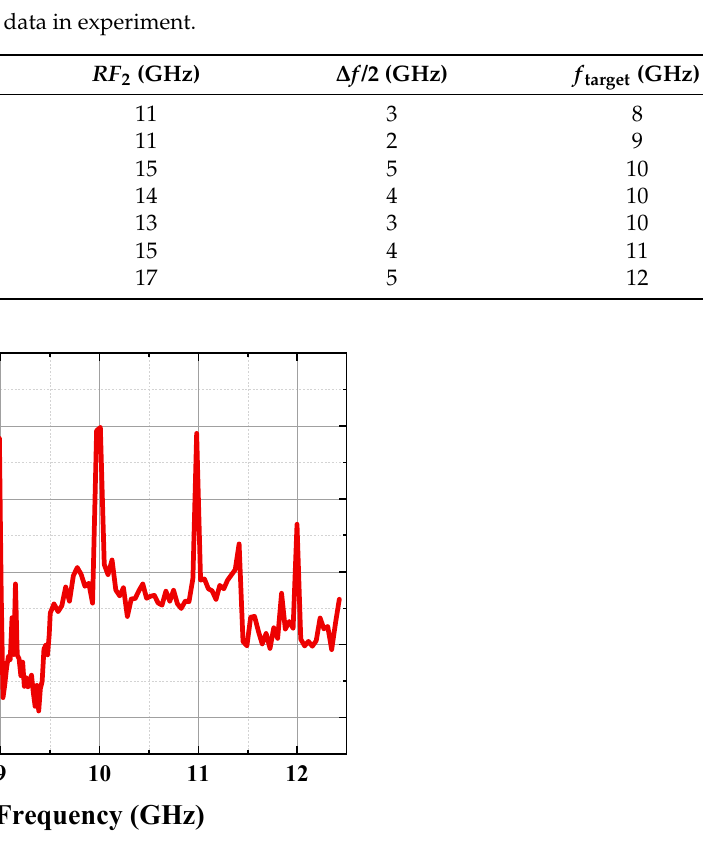
Figure 5. Electrical spectrum of the proposed all-optical microwave frequency divider. As shown in Figure 6, with the change in RF 1 and RF 2 signals, we keep the f target as 10 GHz. The RF 1 signal is 5 GHz, 6 GHz, 7 GHz, respectively. The RF 2 signal is 15 GHz, 14 GHz, 13 GHz, respectively. The frequency divider corresponding to the change of different RF 1 and RF 2 signals has different frequency division factors, and the final target frequency signal is 10 GHz. The corresponding power of the state noise and frequency peak value under different frequency division factors is different. By controlling the RF signals, the proposed all-optical microwave frequency divider can achieve different frequency division factors. The systems parameters such as optical power and SL frequency can be optimized to extend the signal noise rate (SNR). In Figure 6, the State1 ( RF 1 = 5 GHz, RF 2 = 15 GHz) has the SNR over 22 dBm, and the State 2 ( RF 1 = 6 GHz, RF 2 = 14 GHz) and the State 3 ( RF 1 = 7 GHz, RF 2 = 13 GHz) have the SNR about 18 dBm and 12 dBm, respectively. This is caused by the different RF signals value. For the influence of optical power for oscillation state, the ML power was changed accordingly as the input RF signal frequency value to ensure the SL was in P2 state.